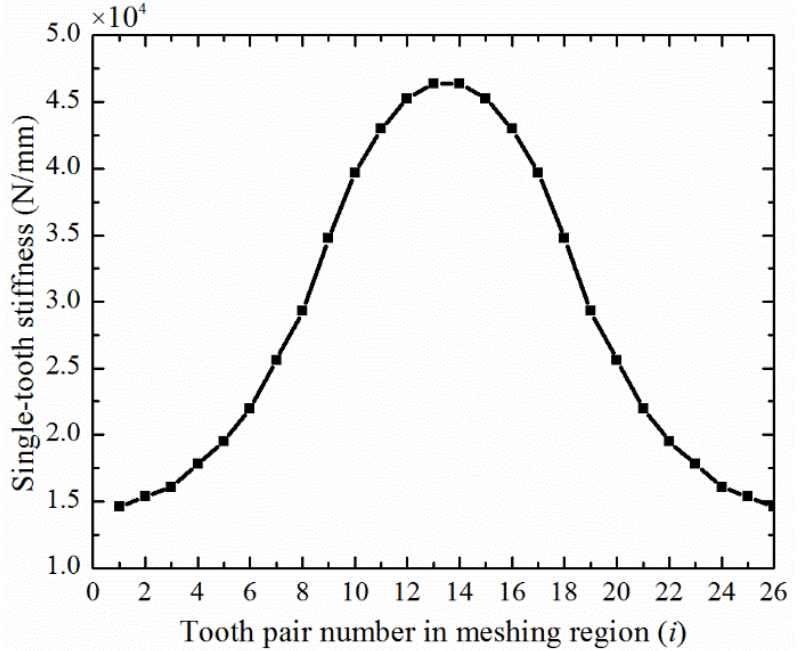
Figure 12. Single-tooth stiffness of the disposable harmonic gear.